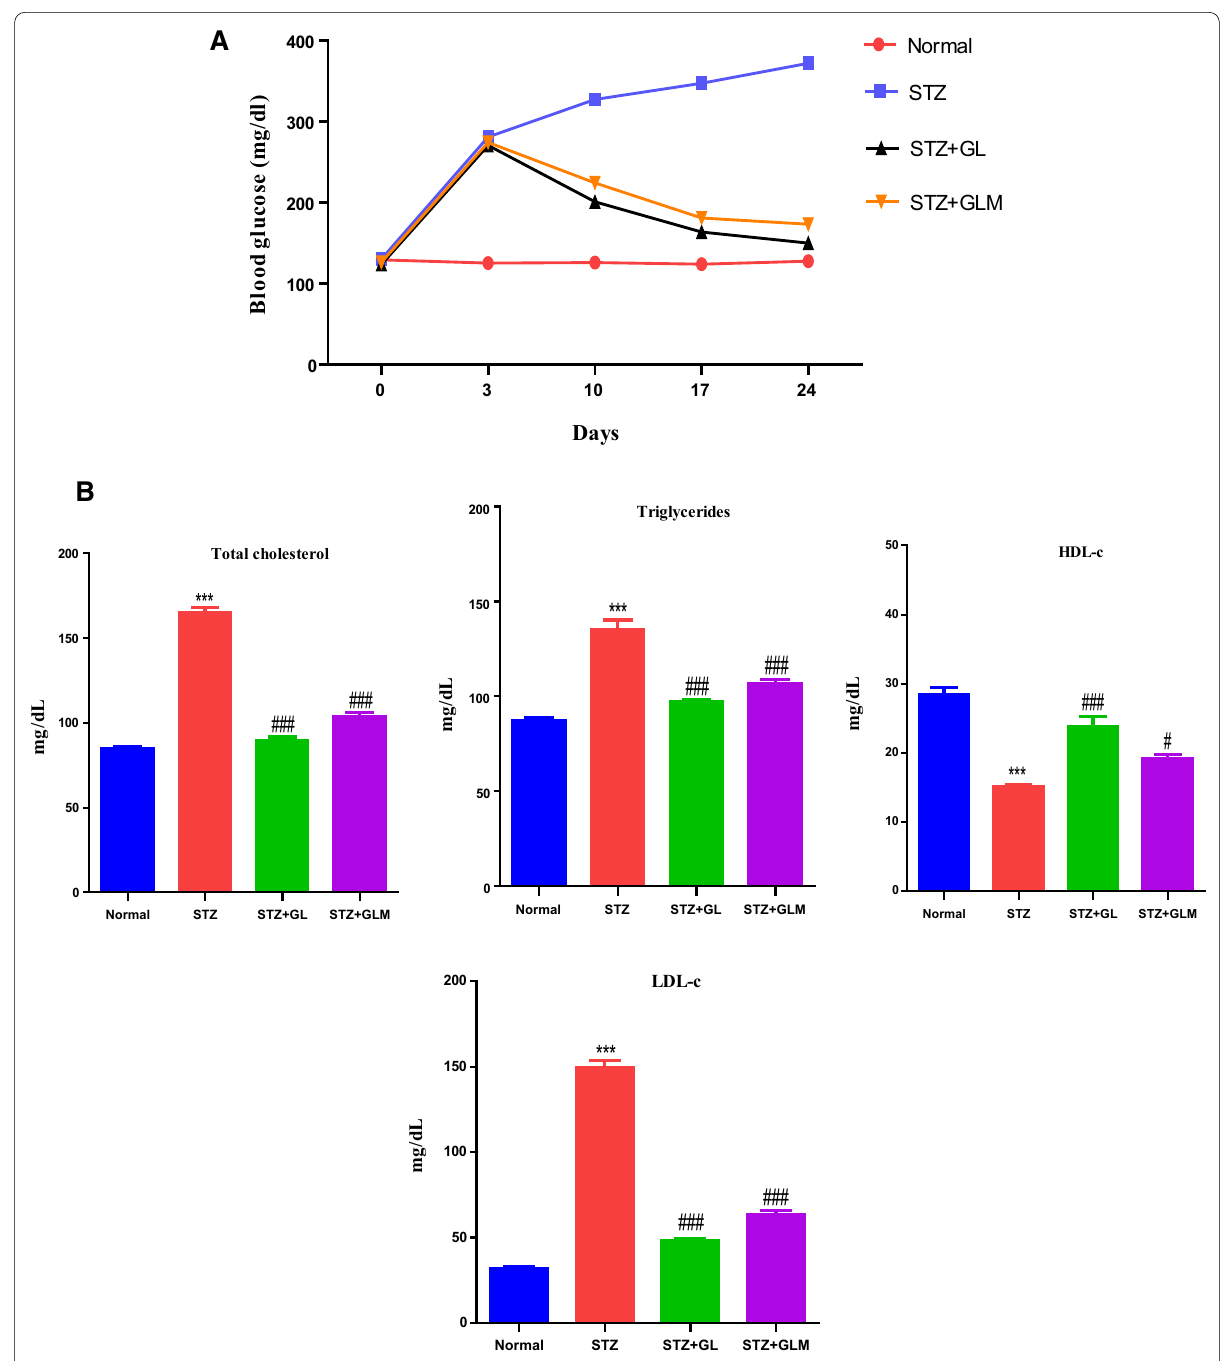
Fig. 8 The STZ diabetic model used for estimation of the effective nature of the prepared microsphere is resembled here. As seen in the red line, there was no such enhancement of serum blood glucose level when estimated at different time interval of 0 days, 3 days, 10 days, 17 days and 24 days. The blue line indicates the gradual increase in serum blood glucose level at different time interval for the STZ treated group ( A ). Similarly, the black line and the yellow line represent the effectiveness of the standard drug glibenclamide and the prepared MSB-Starch microsphere loaded with gliclazide, respectively, in controlling the serum blood glucose level when estimated in the given time interval. The effect of the microsphere on the lipid profile like total cholesterol, triglycerides, HDL-c and LDL-c is represented here. There was a subsequent increase in the total cholesterol, triglycerides, LDL-c level with the overall decrease in the HDL-c level as seen in the STZ treated group represented by the red block ( B ). There was no such alteration in the above parameters in the normal group as seen in the blue block. The green and violet block represents the effectiveness of the standard drug glibenclamide and the prepared microsphere in the management of the lipid